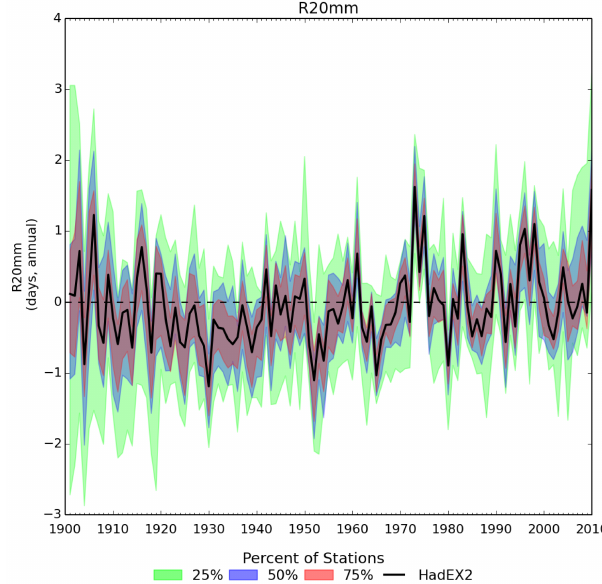
Figure 18. As for Fig. 17b but showing the time series for the global Fig. 18. As for Fig. 17b but showing the time series for the global average of R20mm for the sub-sampling runs. All choices have been average of R20mm for the sub-sampling runs. All choices have centred relative to the climatology period 1961–1990, reducing the been centered relative to the climatology period 1961-1990, reduc- spread during this ing the spread during this time.